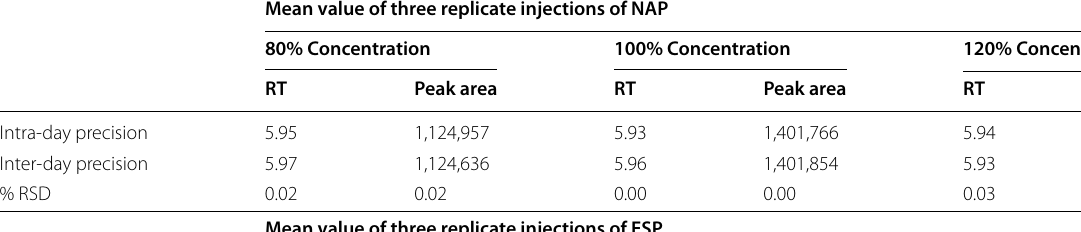
Table 6 Repeatability and intermediate precision of ESP and